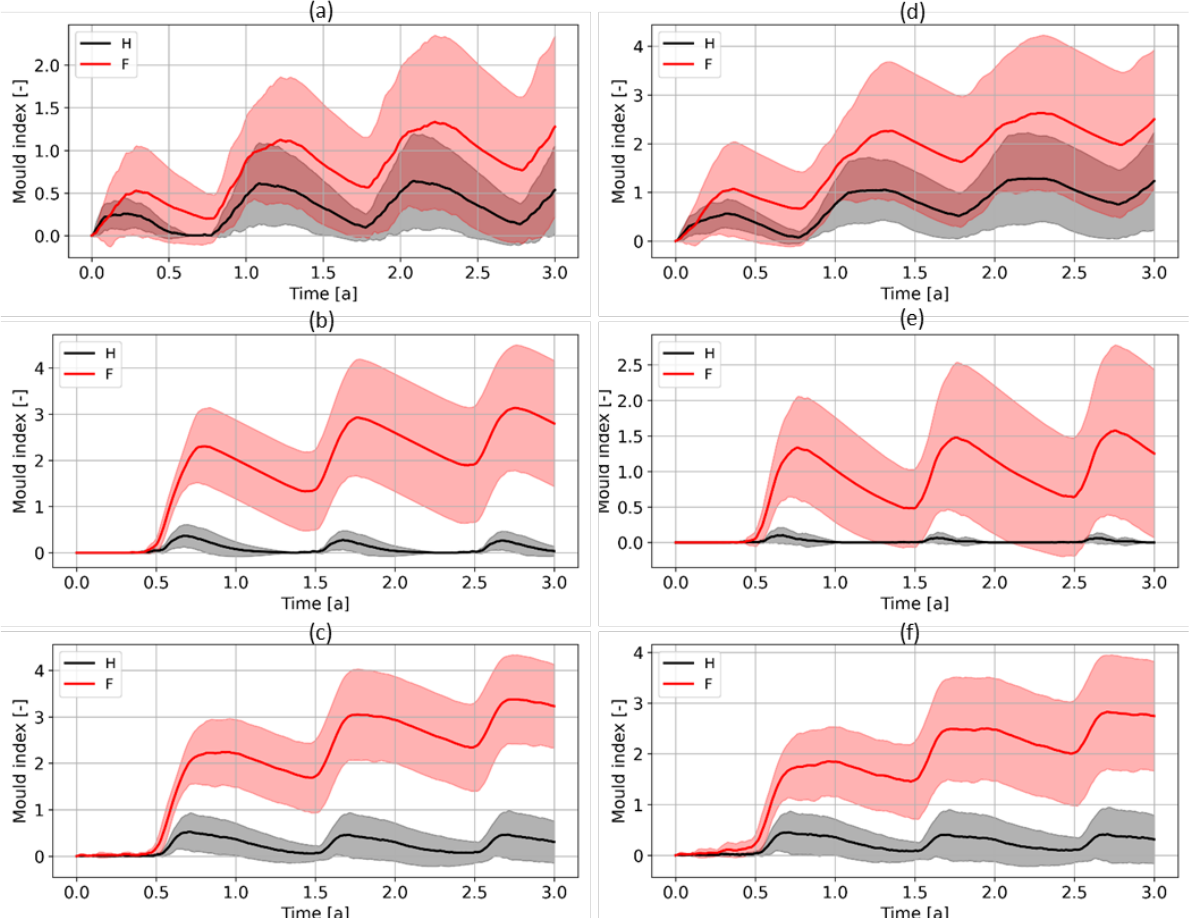
Figure 8. Examples of mold growth index profiles obtained for the vented design over the three repetitions of the test year for fiber cement board (FCB) and aluminum composite material (ACM) claddings when a moisture source (MS) of 1% was considered: ( a ) FCB, Vancouver; ( b ) FCB, Montreal; ( c ) FCB, Halifax; ( d ) ACM, Vancouver; ( e ) ACM, Montreal; ( f ) ACM, Halifax. The black and red lines represent the average of the 15 realizations of historical and future periods, respectively, whereas the area represents +/ − 1 standard deviation. Hourly values were daily averaged.